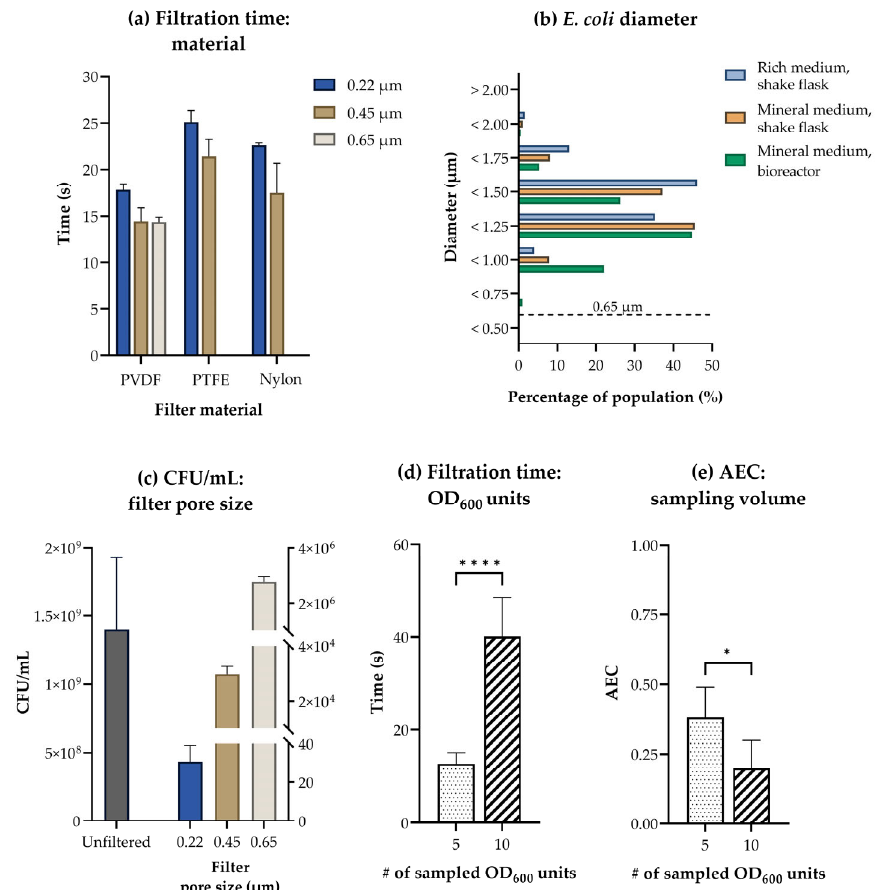
Figure 2. Effects of filter material, pore size, and sampled biomass. ( a ) Filtration times (s) for five OD 600 units of E. coli rinsed with 10 mL warm (37 ◦ C) water under a controlled vacuum on polyvinylidene difluoride (PVDF), hydrophilic polytetrafluoroethylene (PTFE), and nylon filters with a pore size of 0.22 µ m, 0.45 µ m, or 0.65 µ m. The average ± SD of n = 3–4 technical replicates is presented. ( b ) The proportions of E. coli from three common laboratory setups belonging to different diameter-ranges ( µ m), as estimated by light microscopy. Presented for rich medium in shake flask, mineral medium in shake flask, and mineral medium in bioreactor. The largest filter pore size included in this study is indicated by a dashed line. The average of 1–3 biological replicates, each with n ≥ 5 technical replicates is presented. More than 350 cells were measured per biological replicate. ( c ) Colony forming units (CFU)/mL in five OD 600 units of an unfiltered E. coli culture, and in the corresponding E. coli filtrate from PVDF filters with a pore size of 0.22 µ m, 0.45 µ m, and 0.65 µ m. The average ± SD of n = 3 technical sampling replicates each plated in 1–3 parallels is presented. ( d ) The filtration time (s) and ( e ) adenylate energy charge (AEC) measured for five and ten OD 600 units of E. coli rinsed with 10 mL warm (37 ◦ C) water under a controlled vacuum on PVDF filters with a pore size of 0.45 µ m. The average of n = 4–8 replicate samplings is presented. Significance levels from two-tailed t -tests assuming equal variances are marked in ( d , e ) *: p ≤ 0.05; ****: p ≤ 0.0001. #;